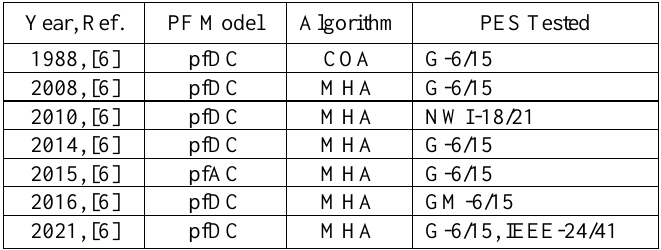
Table 1: Active power loss represented in the OF.